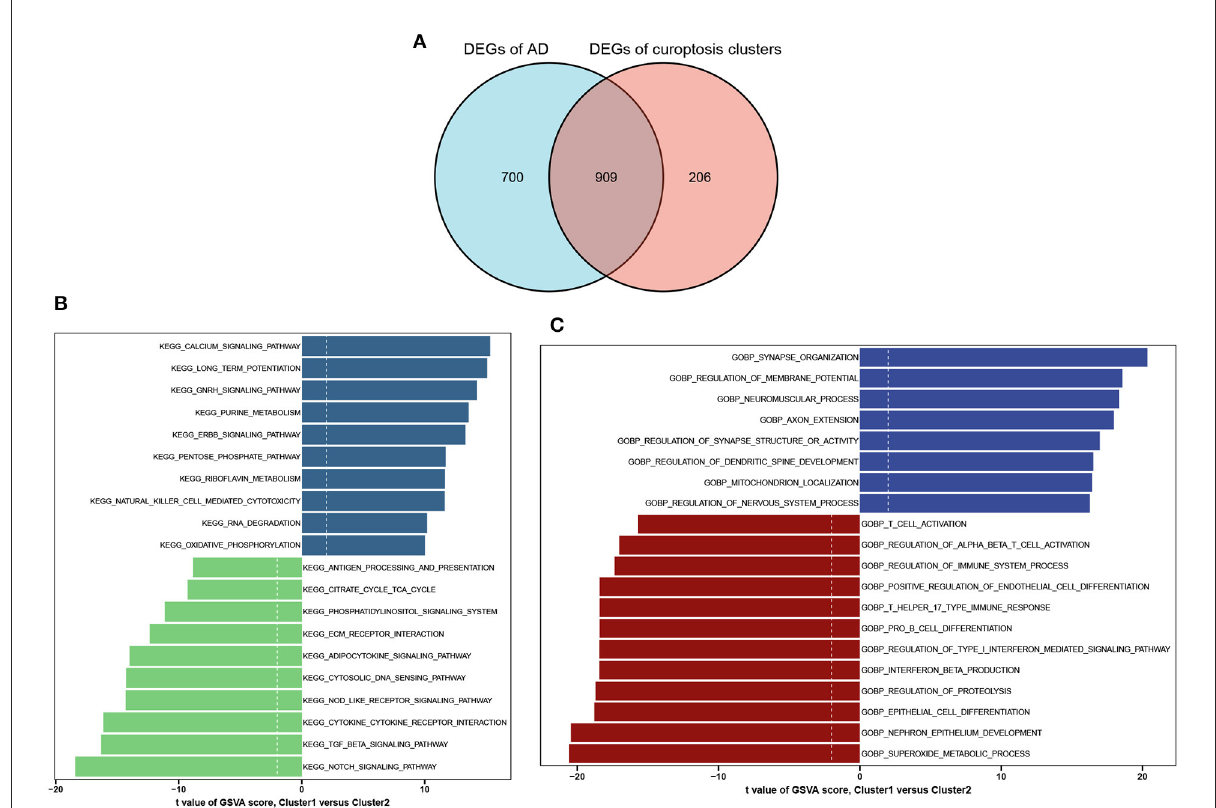
FIGURE7 Identification of cluster-specific DEGs and biological characteristics between two cuproptosis clusters. (A) The intersections between module-related genes of cuproptosis clusters and module-related genes in the GSE33000 dataset. (B) Differences in hallmark pathway activities between Cluster1 and Cluster2 samples ranked by t -value of GSVA method. (C) Differences in biological functions between Cluster1 and Cluster2 samples ranked by t -value of GSVA